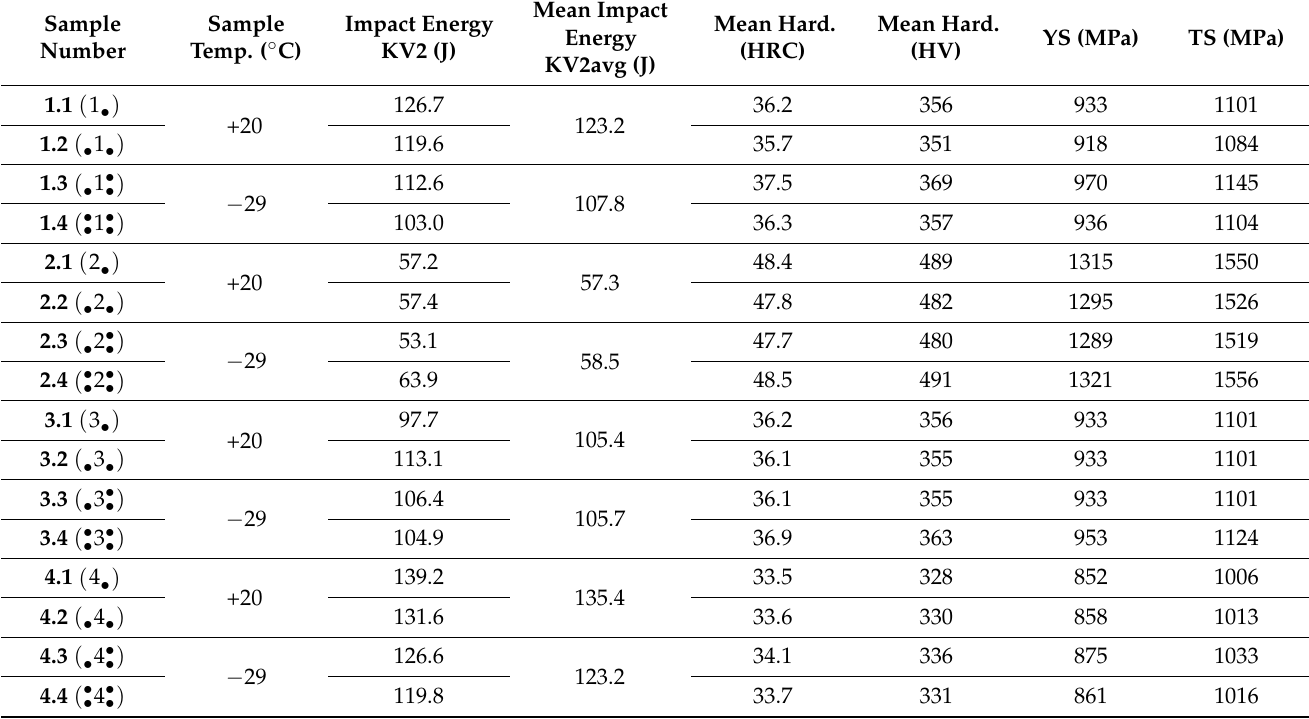
Table 8. Experiment results: impact energy, hardness, yield and tensile strength.